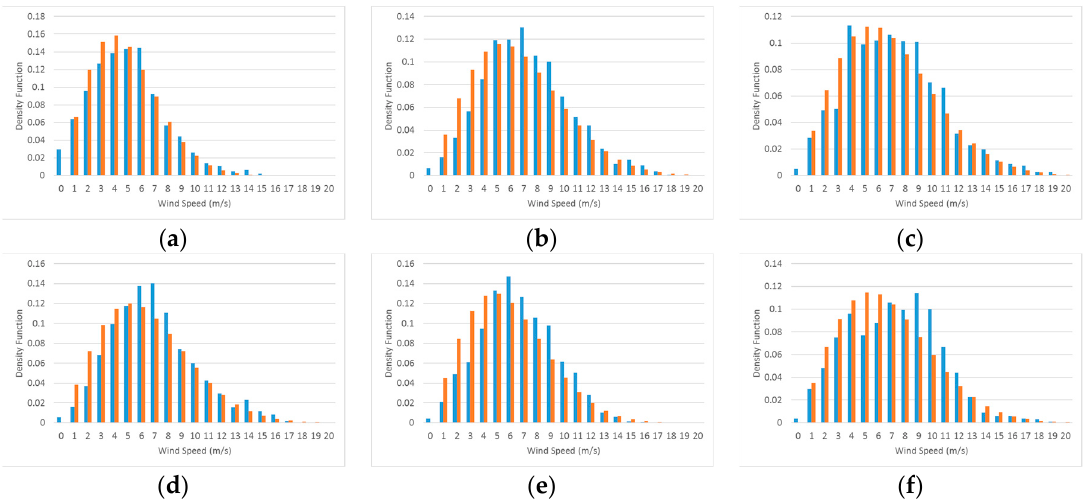
Figure 10. Six groups of samples of normalized histograms of wind speeds, in blue, and fitted Weibull distribution, in orange, for group periods of 20 days each during WS season. Each graph corresponds to the following period ( a ) 01/01/2010–01/20/2010; ( b ) 01/21/2010–02/09/2010; ( c ) 02/10/2010– 03/01/2010; ( d ) 03/02/2010–03/21/2010; ( e ) 03/22/2010–04/10/2010; ( f ) 04/11/2010–04/30/2010.